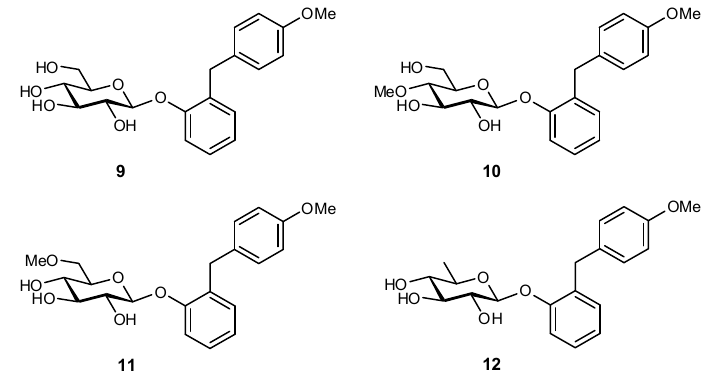
Figure 3. Sergliflozin-A ( 9 ) is an inhibitor of sodium glucose co-transporter 2 (SGLT2) but is ineffective as a therapeutic against diabetes due to its poor metabolic stability. A library of Sergliflozin-A derivatives identified the 4- O -methylated derivative 10 as having similar potency to Sergliflozin-A but enhanced pharmacokinetic stability [118].